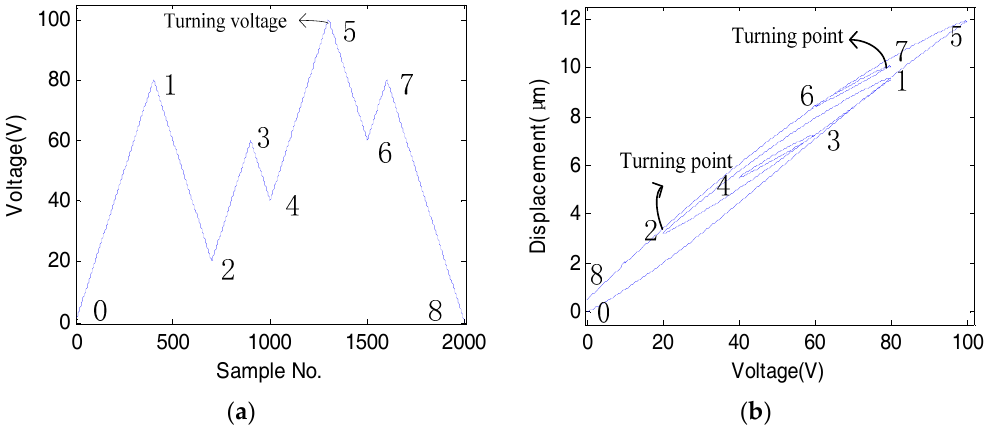
Figure 5. Wiping out effect of hysteresis. ( a ) The input voltage to the PZA; ( b ) the output displacement versus the input voltage.